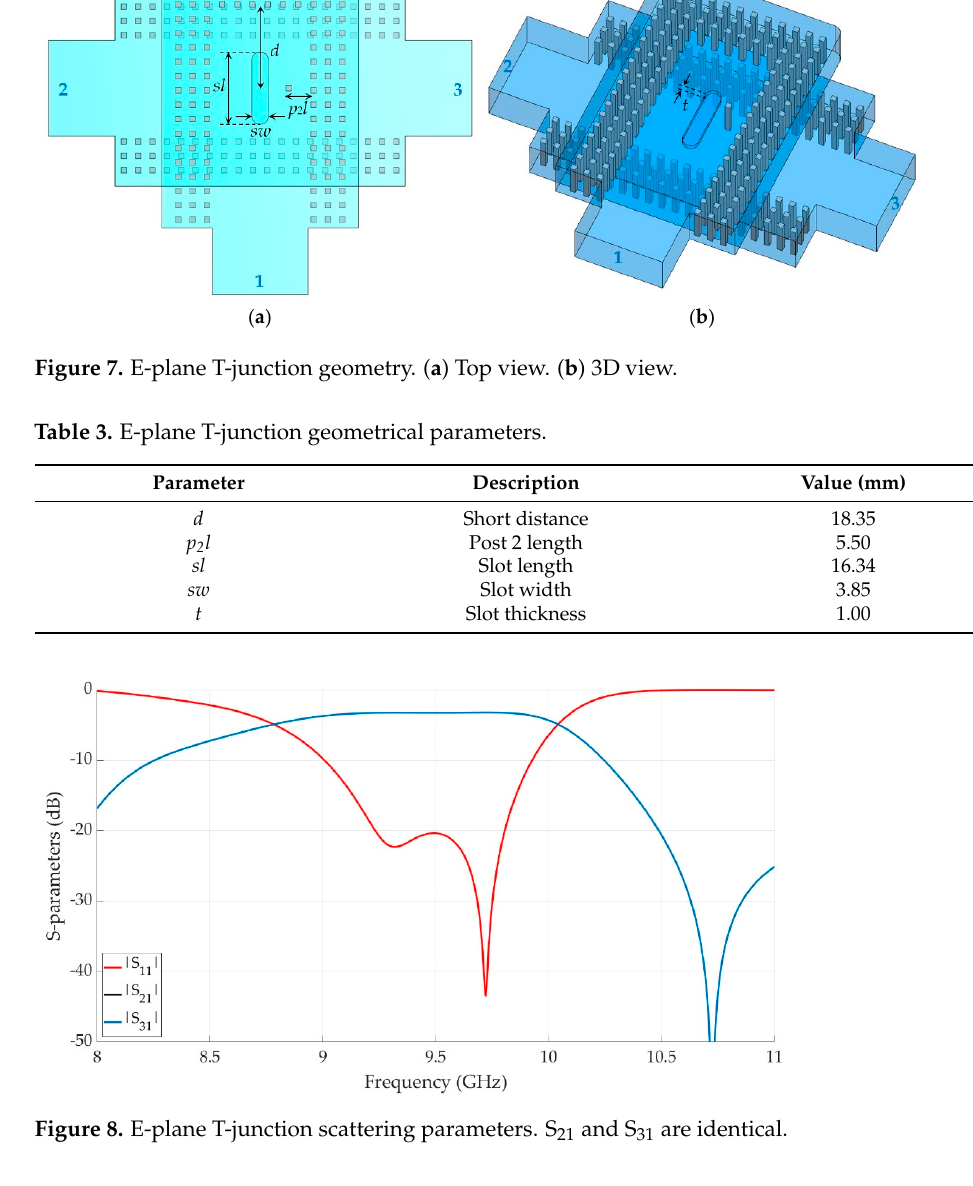
( d ) Figure 9. Magic-T geometry. ( a ) TMT top view. ( b ) TMT 3D view. ( c ) XMT top view. ( d ) XMT 3D view.